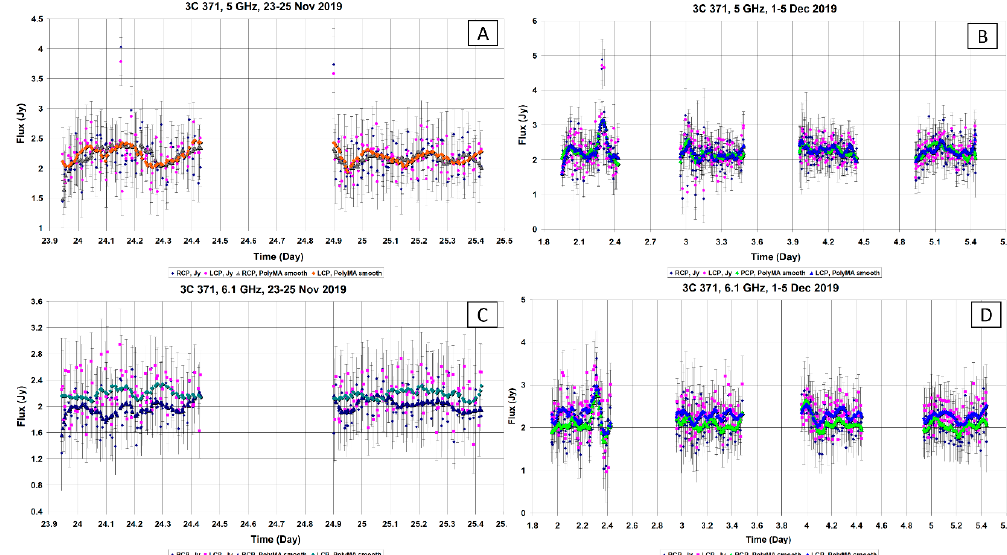
Figure 4. Curves of 3C 371 flux density changes at 5 and 6.1 GHz, points of the initial data with the “whiskers” of the errors are shown, as well as smoothed curves obtained using the Savitzky–Golay filtration procedure. The sections of the plot show the data. ( A ) 23–25 November, 5 GHz; ( B ) 1–5 December, 5 GHz; ( C ) 23–25 November, 6.1 GHz; ( D ) 1–5 December, 6.1 GHz. The average error in measuring the flux density for 5 GHz was 0.37, 0.41 Jy (RCP) and 0.38, 0.42 Jy (LCP) for sessions in November and December, respectively. For a frequency 6.1 GHz, the average flux density measurement error was 0.41, 0.45 Jy (RCP) and 0.46, 0.50 Jy